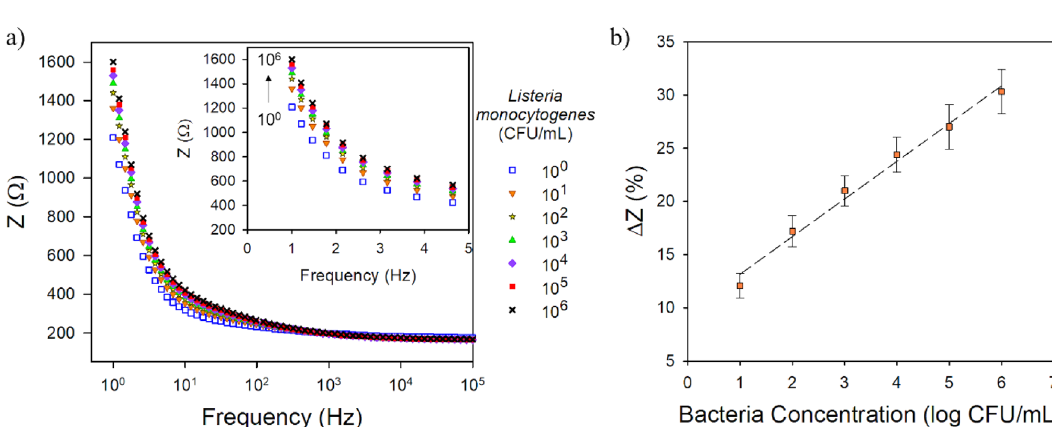
Figure 6. ( a ) Representative Bode plot over the frequency range of 1–100,000 Hz (insets are a zoomed in view of the lower frequency range from 1 to 5 Hz) and ( b ) calibration curve (total impedance change at 1 Hz vs. log bacteria concentration) for the ALG-thiomer/Pt brush sensor functionalized with 400 nM aptamer exposed to L. monocytogenes in chicken broth. Error bars represent the standard deviation of the arithmetic mean of at least three